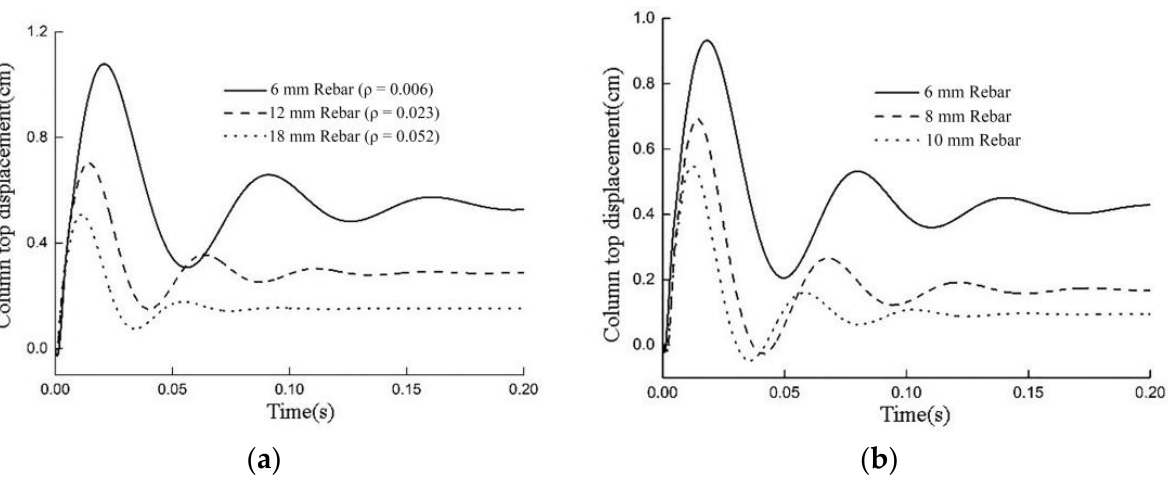
Figure 20. Relationship between column top displacement and reinforcement ratio: ( a ) relationship between column top displacement and longitudinal reinforcement; ( b ) relationship between column top displacement and stirrup.